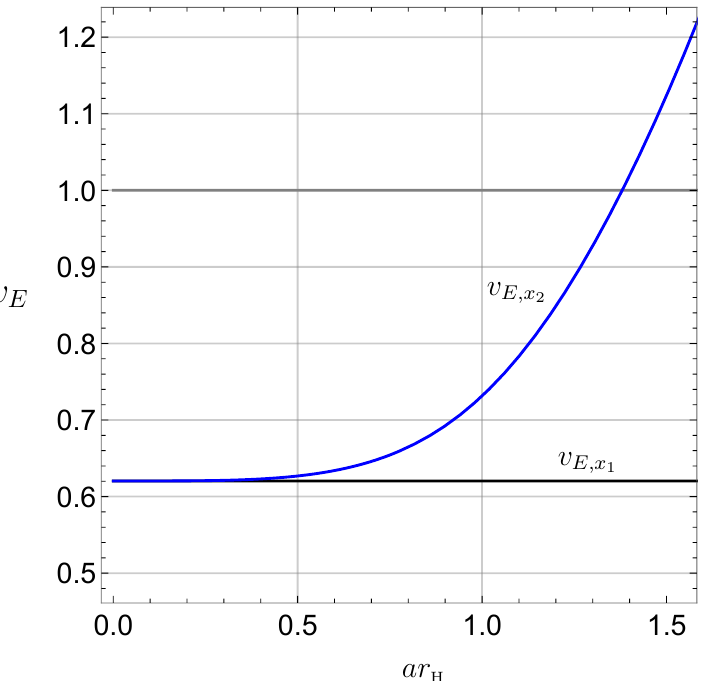
Figure 7 . Entanglement velocity v E versus the dimensionless parameter ar represent the entanglement velocity for a non-commutative strip, while the horizontal black line represent the entanglement velocity for a commutative strip, which is equal to the conformal result p v E = 2 = 3 3 = 4 . The horizontal grey line represents the speed of